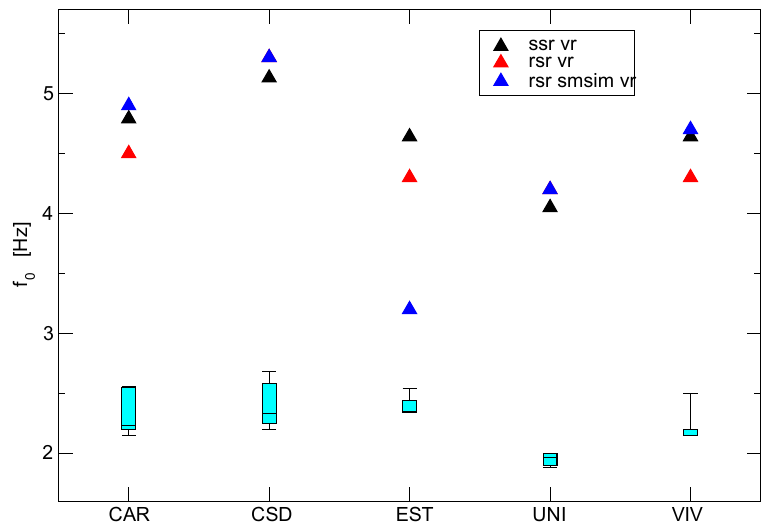
Figure 10. Triangles: Fundamental frequency for the vertical component at the five sites where aftershocks were recorded, obtained from the different methods used to estimate site response. The boxes show the average fundamental frequency for the two horizontal components: The limits of the box show the lower and upper quartiles, the whiskers indicate the lower and upper extreme values, and the line inside the box indicates the median value.